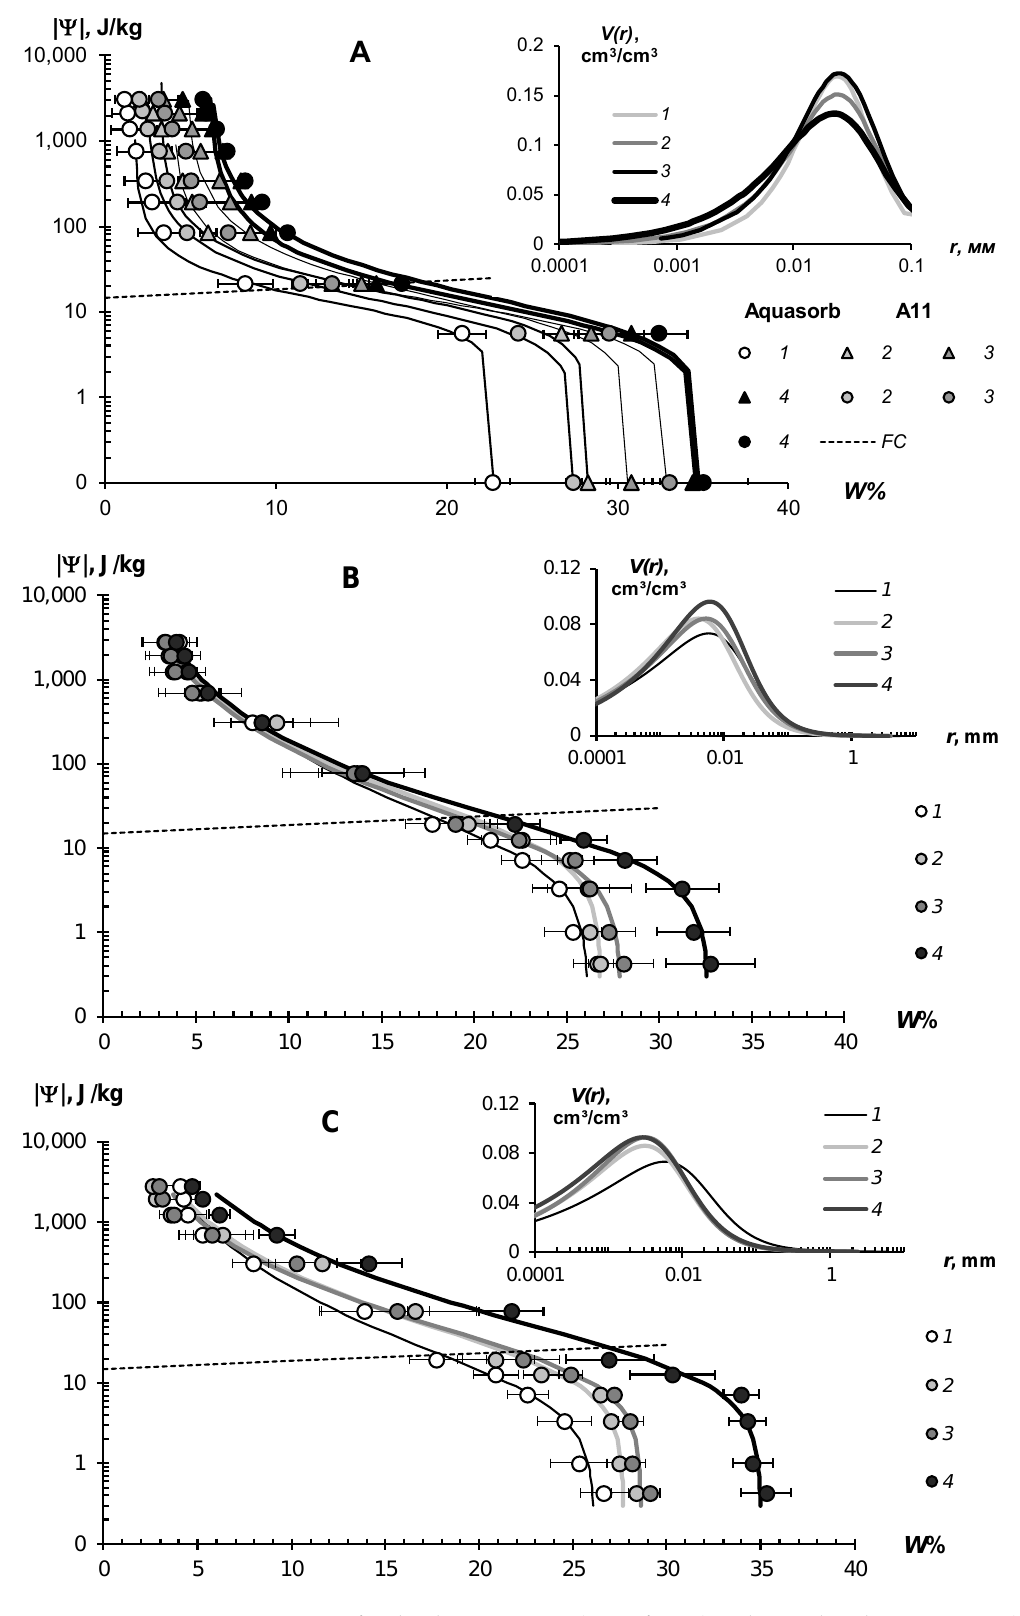
Figure 8. WRC of soil-gel composition (main figure) and pore distribution curves (inset) in loamy- sandy Arenosols. ( A ) — Aquasorb and A11 in Karakum Desert Arenosol; ( B ) — Aquasorb and ( C ) — A22 in Dubai Arenosol; 1 — untreated control; 2 — 0.1% gel dose; 3 — 0.2% gel dose; 4 — 0.2% gel dose.